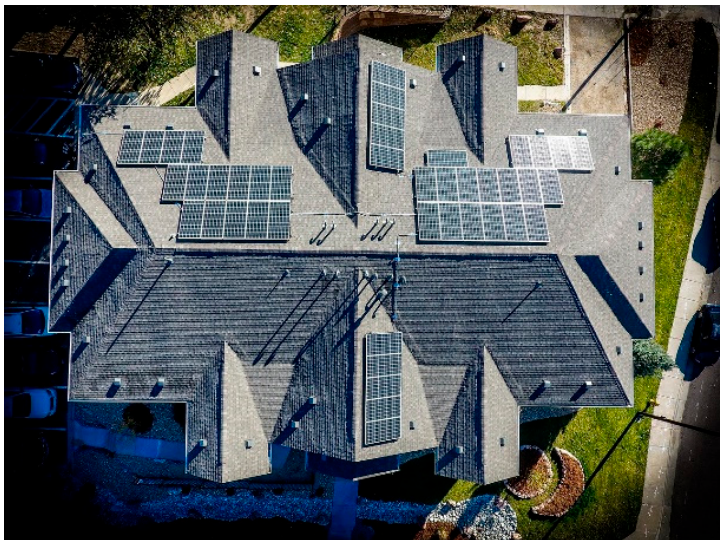
( b ) Figure 3. Spatial dimensions: ( a ) azimuth and ( b ) tilt. CONNECTION WITH THE SUN: STATIC OR DYNAMIC The tilt and azimuth of the Sun in relation to a surface point are changing through time. Any surface of the object may be static (or stationary) or dynamic. If the surface is static, the surface points have tilt and azimuth defined and not changing. This means that for every surface point, the difference between the tilt and azimuth of the point and the relative tilt and azimuth of the Sun are known at any moment. If the surface is dynamic, the tilt and azimuth of any point on this surface will be changing depending on the move of this surface, and the difference between the tilt and azimuth of the point and the relative tilt and azimuth of the Sun have to be calculated for any moment. OBSTRUCTION OF SUNLIGHT AND SOLAR ENVELOPE Sunlight incident on a surface may be obstructed by surrounding objects (e.g., a tree, a building, a hill, or a moving truck), which reduces the ability to harvest energy. The shading effect depends on the nature of the obstructing objects and is generally proportional to the altitude angle to the top of the object and spread of the azimuth angle